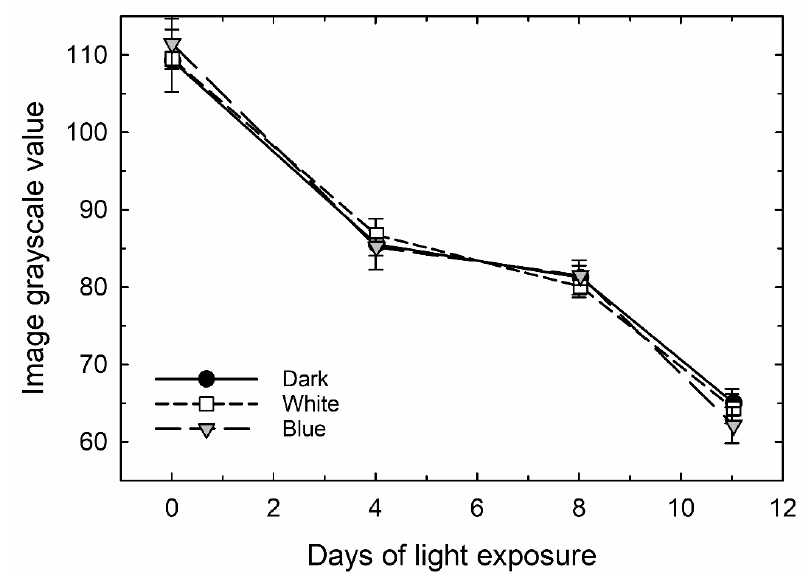
Figure 4. Ripening of green stem-end spots on mature ‘Farthing’ southern highbush blueberries under three light treatments in cold storage. Image analysis grayscale values are scaled between 0 (black) and 255 (white); hence, the lower the value, the more blue the spot on the berries. Values are means and standard errors of five replicate groups of berries per treatment. One-way analysis of variance was performed between the three treatments (blue, white and dark). Differences were non-significant (α = 0.05) at the times after exposure when measurements were performed.